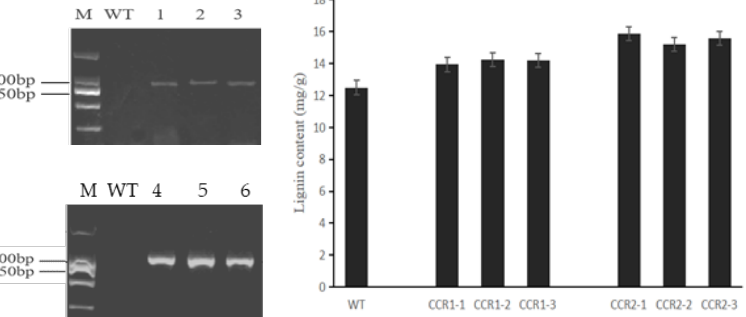
Figure 9. PCR and lignin content detection of Arabidopsis thaliana . Note: CCR1-1, CCR1-2, and CCR1-3 were three different CCR1 transgenic Arabidopsis plants. CCR2-1, CCR2-2, and CCR2-3 were different CCR2 transgenic Arabidopsis plants. M: DL2000 marker; 1 – 3: CcCCR1 transgenic plants,